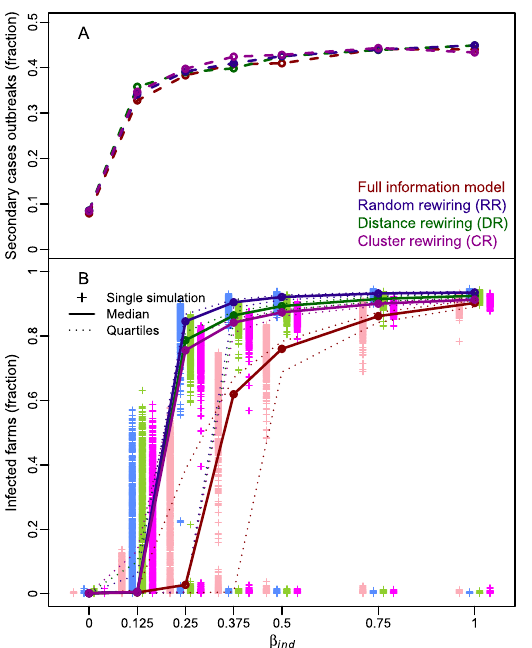
Figure 5. Epidemic simulations with indirect contacts rewiring models. Results of the simulations comparing the full-information model (magenta) with the distance rewired (DR, green), random rewired (RR, blue), and clustered rewired (CR, purple) indirect contacts models. Panel (A) dashed lines represent the fraction of epidemics with secondary cases. Panel (B) the distribution of the number of infected farms (crosses), with the median (thick line), and the 25 th and 75 th quantiles (dotted